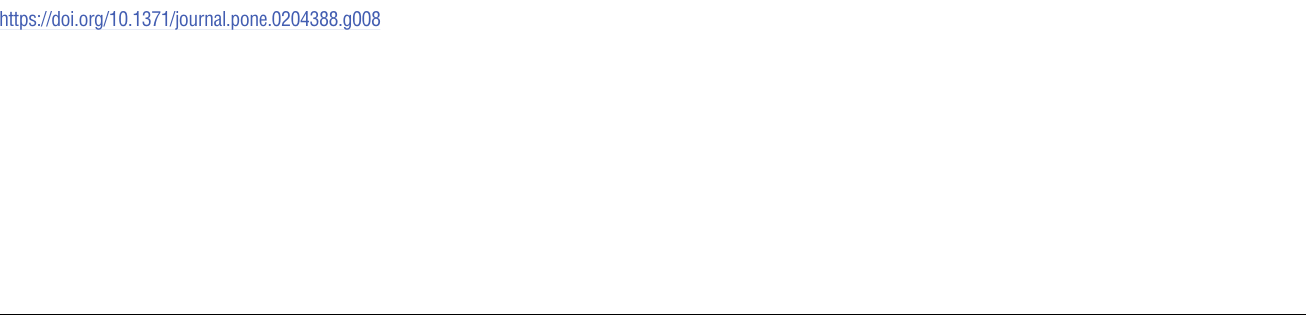
Fig 8. Deterioration of hV4 was present in the left hemisphere of Subject 2 post correction, where a large amount of ipsilateral coverage appeared in the pRF density plot and the polar angle map is considerably disturbed (17.4% less smooth after correction). However, these effects largely disappeared after correcting only inverted voxels with a correlation stronger than